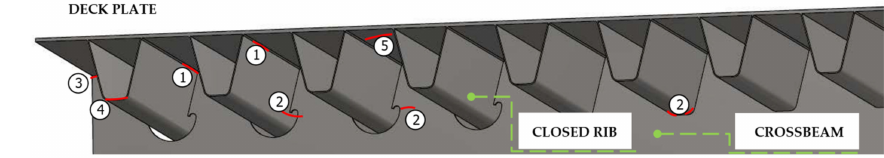
Figure 6. Nomenclature details—Eurocodice EN1993-1-9.